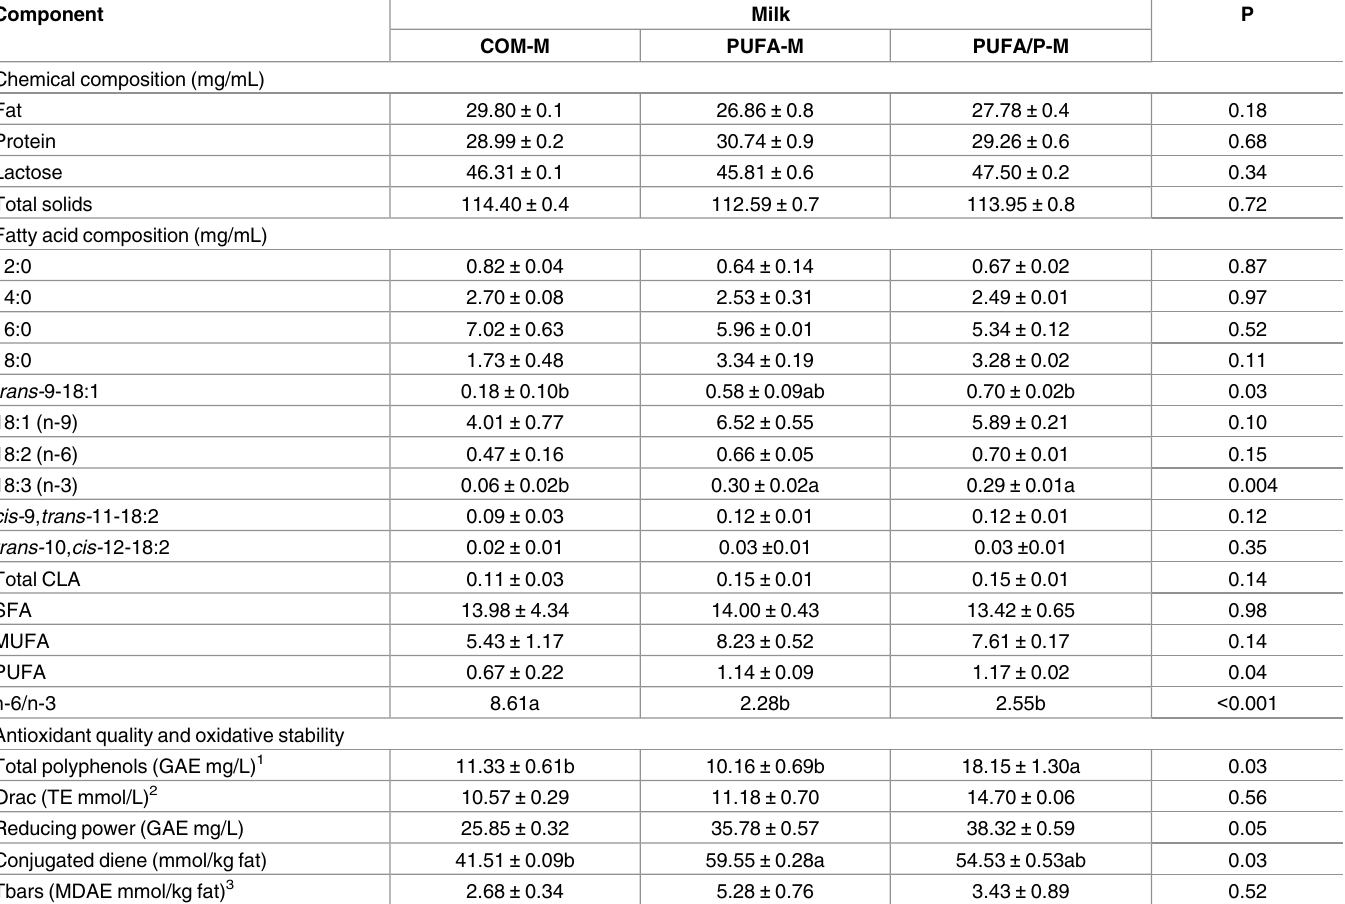
Table 1. Composition of common milk (COM-M), milk enriched with polyunsaturated fatty acids (PUFA-M) and milk enriched with PUFA and poly- phenols (PUFA/P-M).